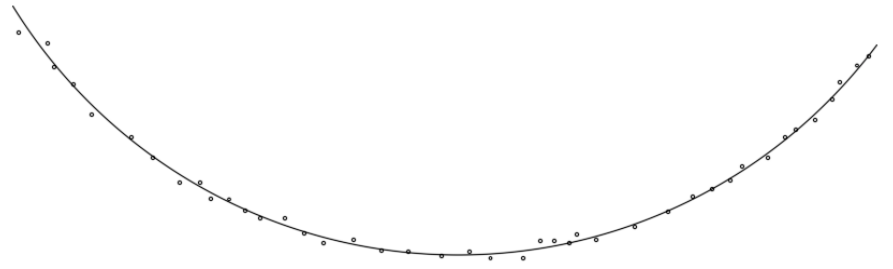
Figure 1. A least square circle fitting example.